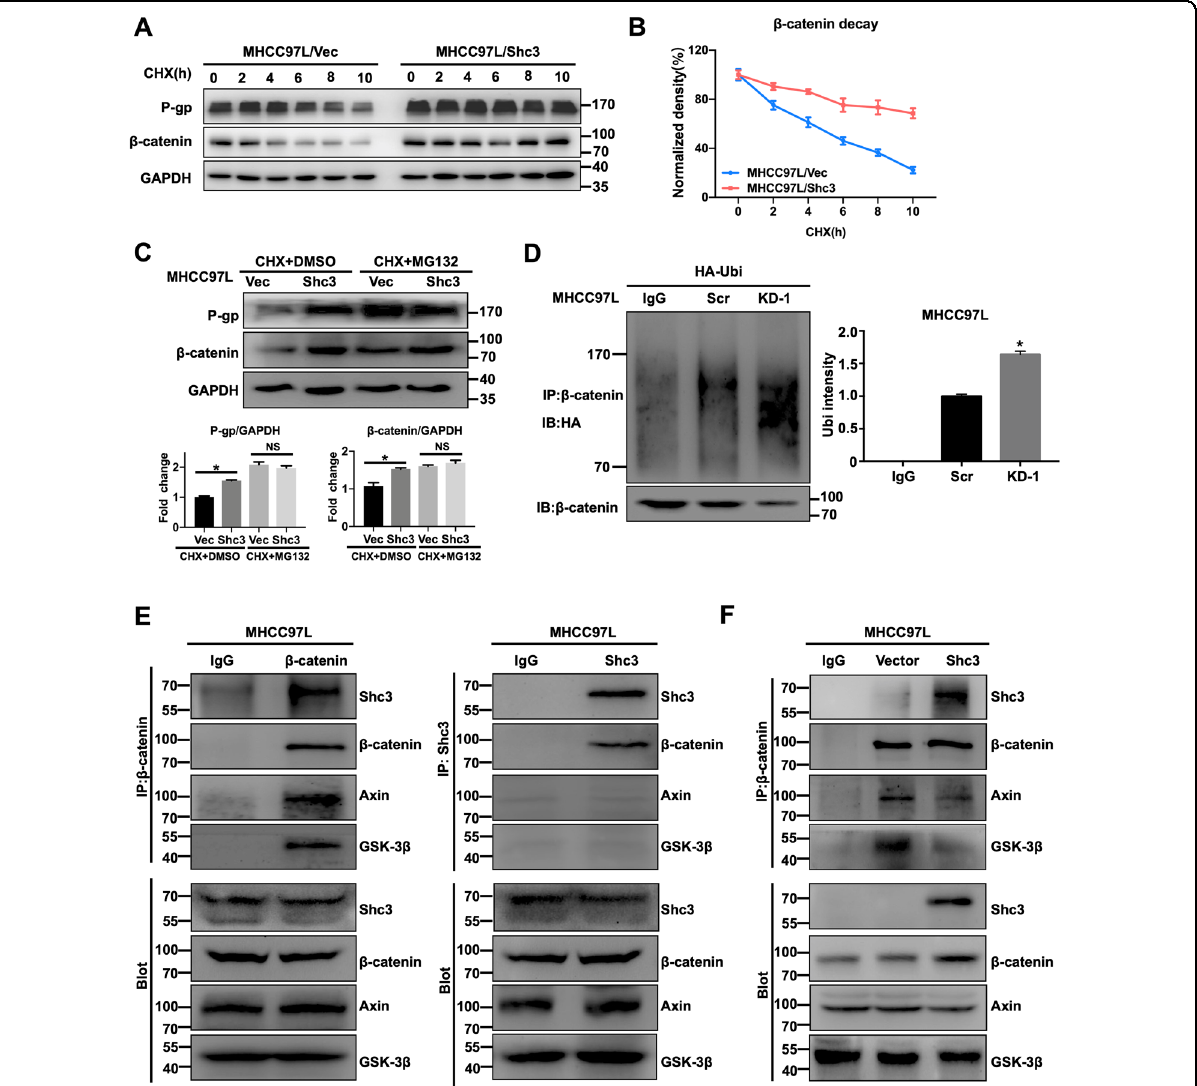
Fig. 5 Shc3 promotes β -catenin release from the destruction complex. A Shc3 overexpressed cells and its control cells were treated with CHX (10 μ g/mL), and total proteins were collected at the indicated time points. The protein expression levels of β -catenin and P-gp were examined by western blot assay. B The line graph shows the comparison of the relative intensity of β -catenin and GAPDH through densitometric analysis. C MHCC97L/Shc3 and MHCC97L/Vector cells were incubated with CHX (10 μ g/mL) either with or without MG132 (10 μ M). Up, Western blotting was used to assess the protein expression levels of β -catenin and P-gp. Bottom, the histogram shows the comparison of the relative intensity of P-gp and GAPDH, β -catenin and GAPDH. D Following transfection with the HA-tagged ubiquitin plasmid, MHCC97L/KD-1 cells and MHCC97L/Scr cells were lysised and immunoprecipitated with anti- β -catenin antibody and then detected by western blotting with anti-HA or anti- β -catenin (left). Error bars represent the mean ± SD (* P < 0.05 MHCC97L/KD-1 vs. MHCC97L/Scr, by Student ’ s t -test). E Coimmunoprecipitation of β -catenin, Shc3, Axin, and GSK-3 β , which were pulled down using anti- β -catenin or anti-Shc3 in MHCC97L cells. F Co-IP analysis of destruction complex proteins ( β -catenin, Axin, GSK-3 β ) and Shc3, which were pulled down using anti- β -catenin or an IgG antibody in MHCC97L/Shc3 and MHCC97L/Vector